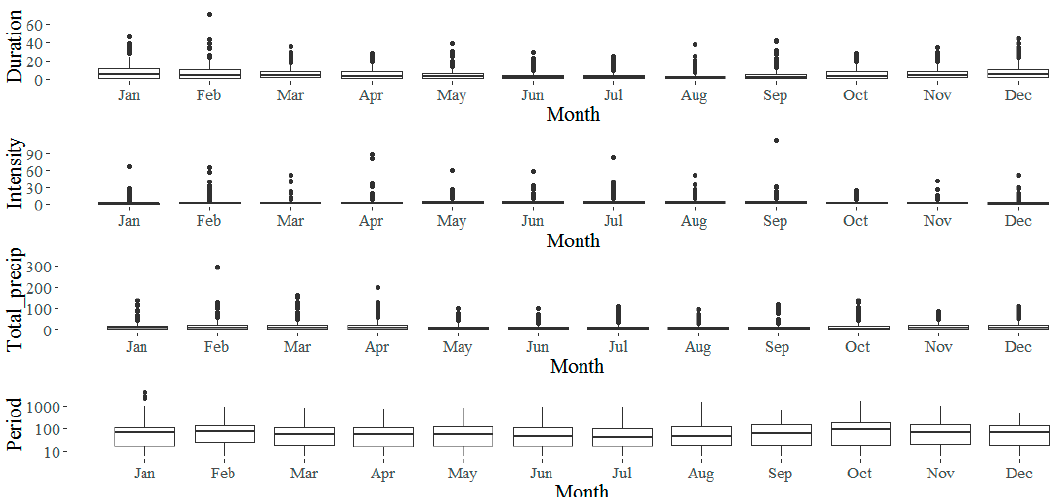
Figure 2. Box and whisker plots for each of the storm properties annual variation showing duration ( row 1 ), intensity ( row 2 ), total precipitation ( row 3 ), and inter-storm period ( row 4 ) values using a one-month bin.